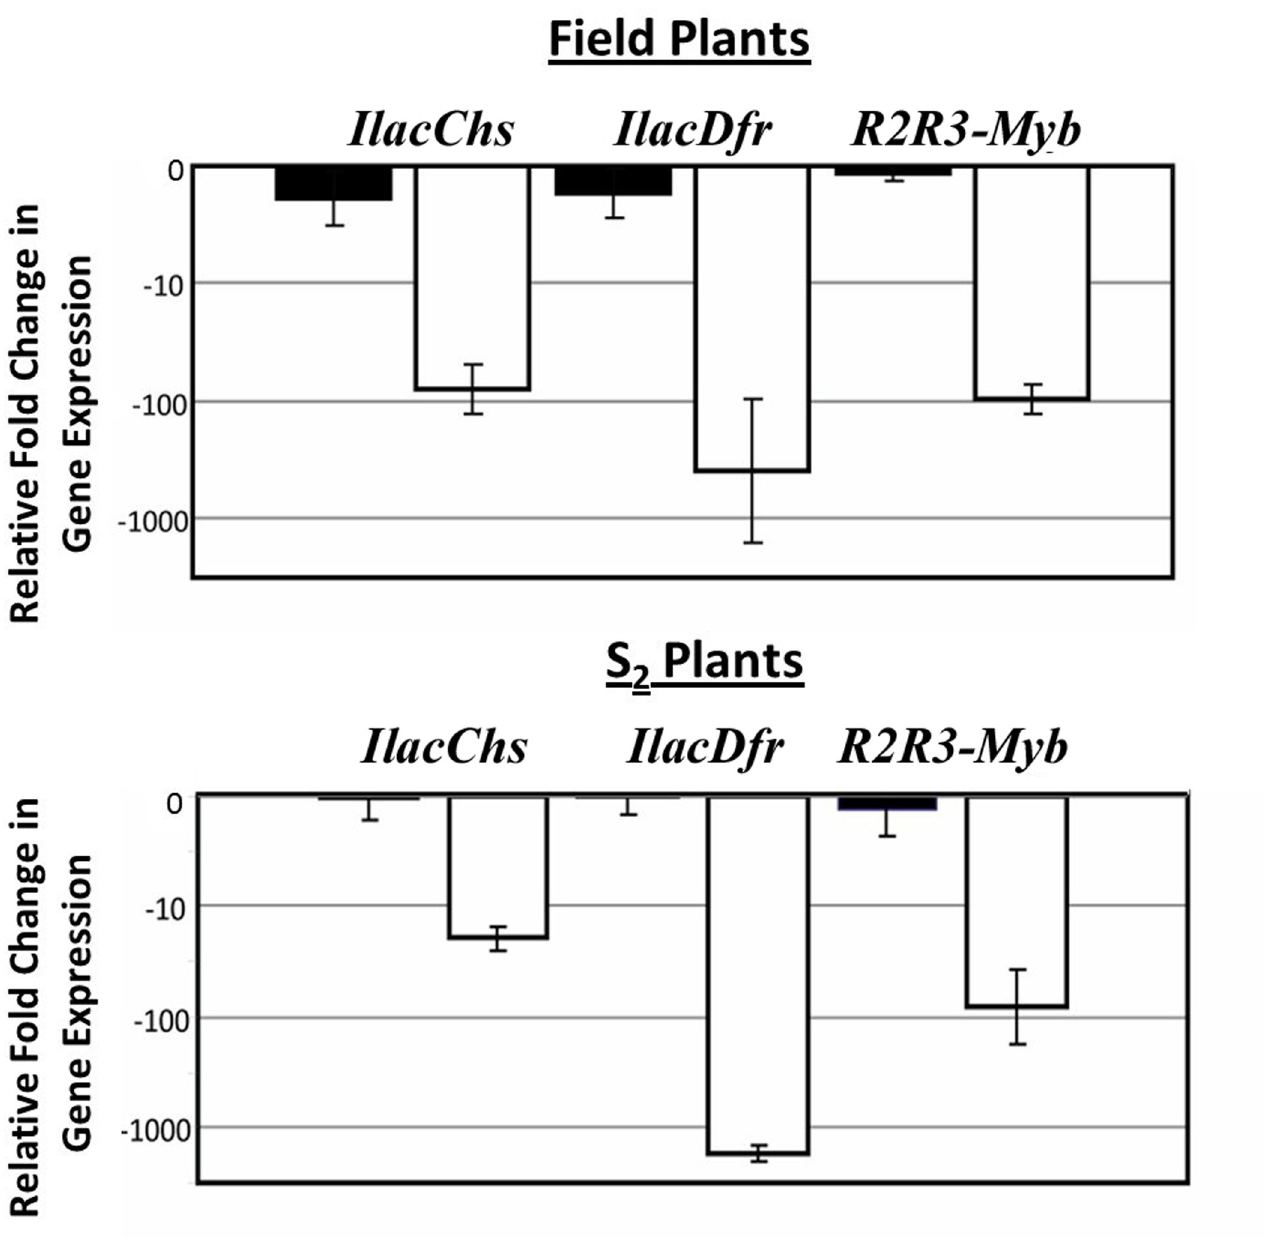
Fig 2. Expression levels of anthocyanin pathway genes in field and S 2 individuals of I . lacunosa . Black bars are purple-flowered individuals, white bars are white-flowered individuals. Error bars indicate standard error. All relative fold changes are relative to a single purple-flowered I . lacunosa . Field individuals: IlacChs ANOVA, F 1,6 = 93.80, p = 0.0002; IlacDfr ANOVA F 1,6 = 39.63, p = 0.0015; IlacMyb1 ANOVA, F 1,6 = 533.95, p < 0.0001; S 2 individuals: IlacChs ANOVA, F 1,6 = 52.14, p = 0.0007; IlacDfr ANOVA, F 1,6 = 554.28, p < 0.0001; IlacMyb1 ANOVA, F 1,6 = 31.44, p =